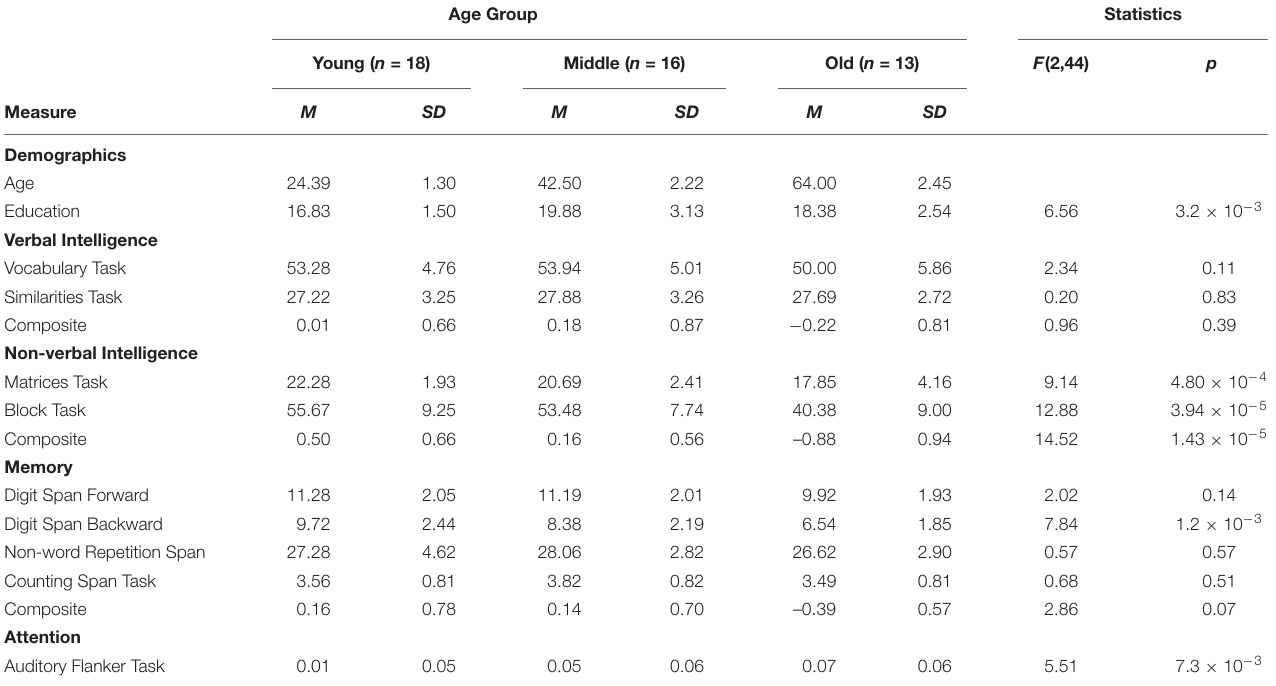
TABLE 1 | Demographics and individual differences ( M = mean, SD = standard deviation).